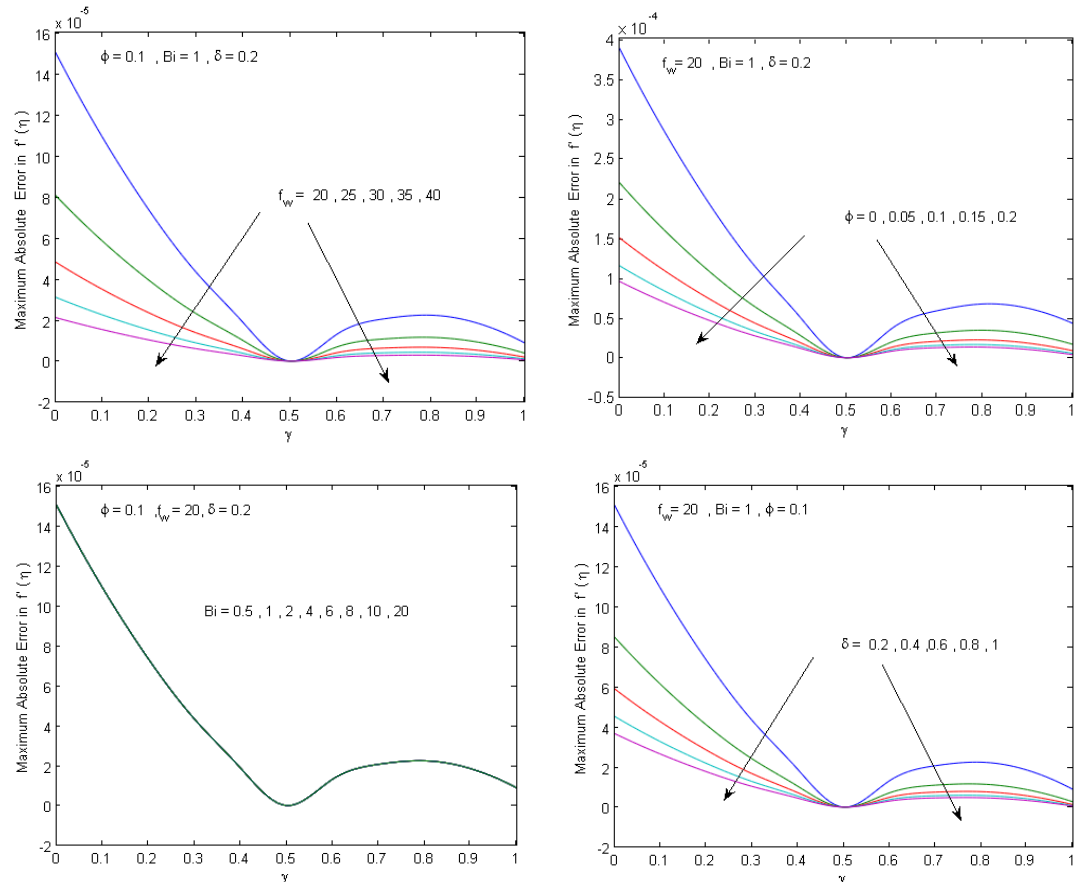
Figure 3. The effect of the physical parameters f w , φ , Bi and δ on the maximum absolute error of the obtained analytical solution ( ) f